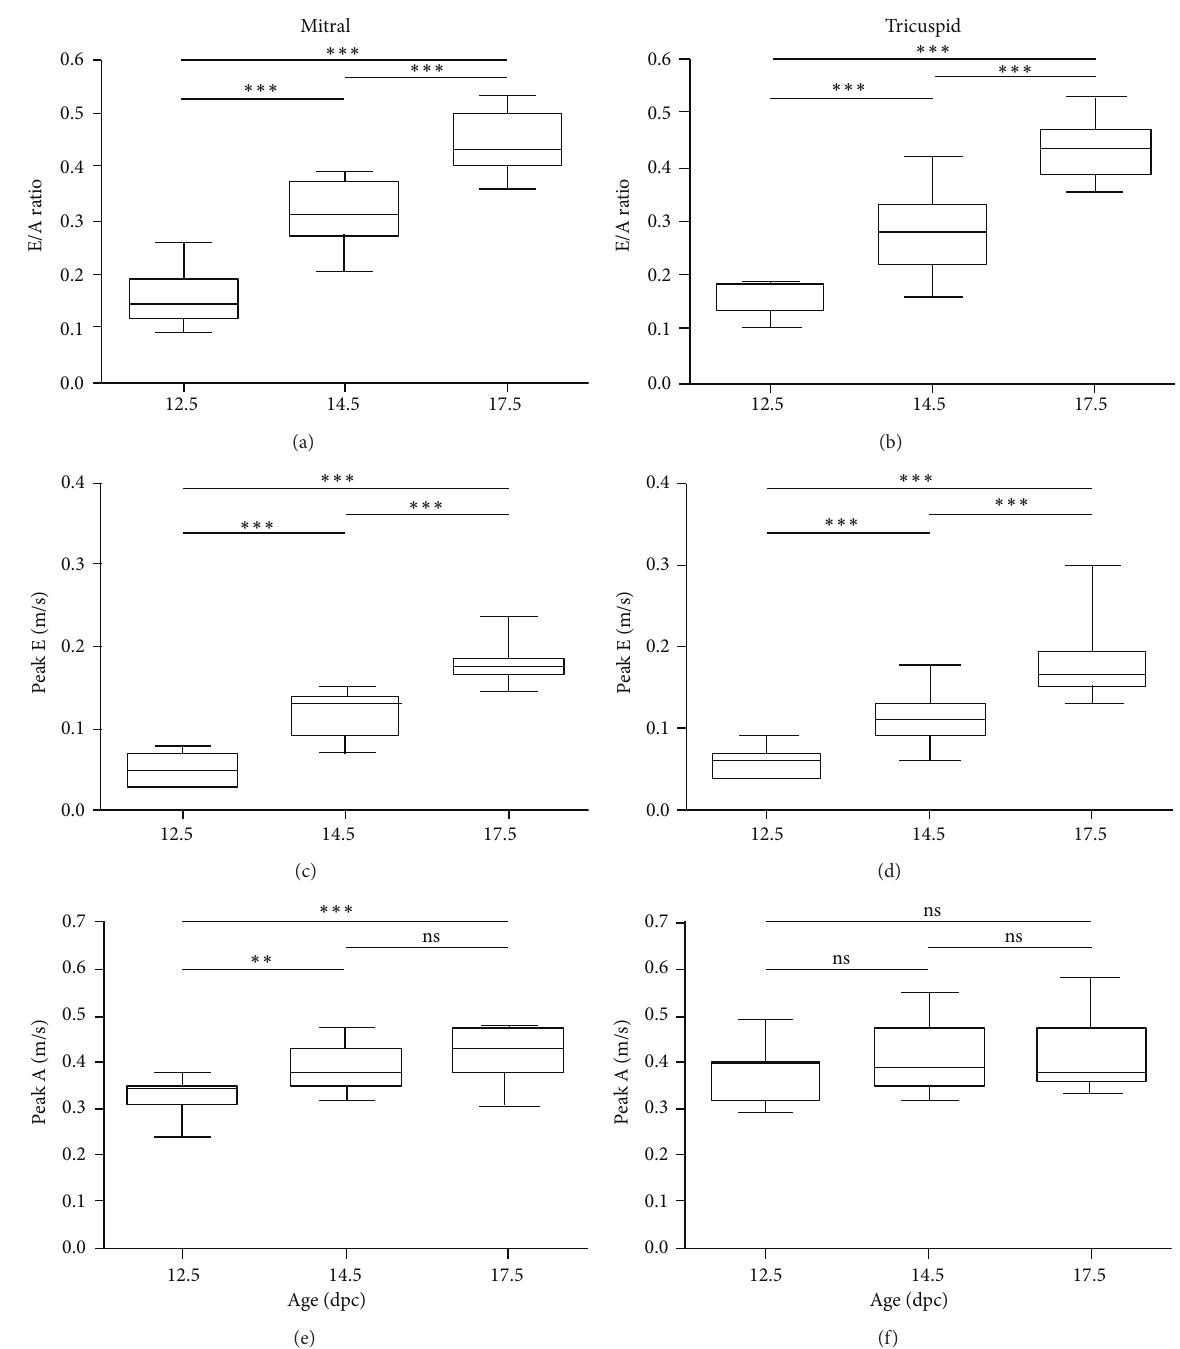
Figure 3: Development of LV and RV inflow patterns. The graphs represent the course of the E/A ratio (a, b), peak-E wave (c, d), and peak-A wave (e, f) across the developing MV and TV at the three subsequent developmental